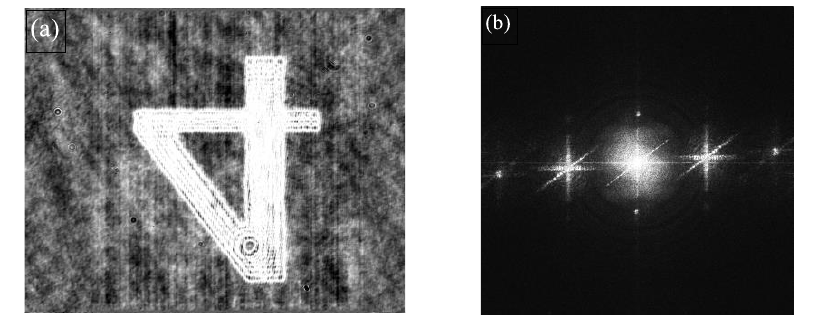
Figure 2. ( a ) Hologram; ( b ) hologram amplitude